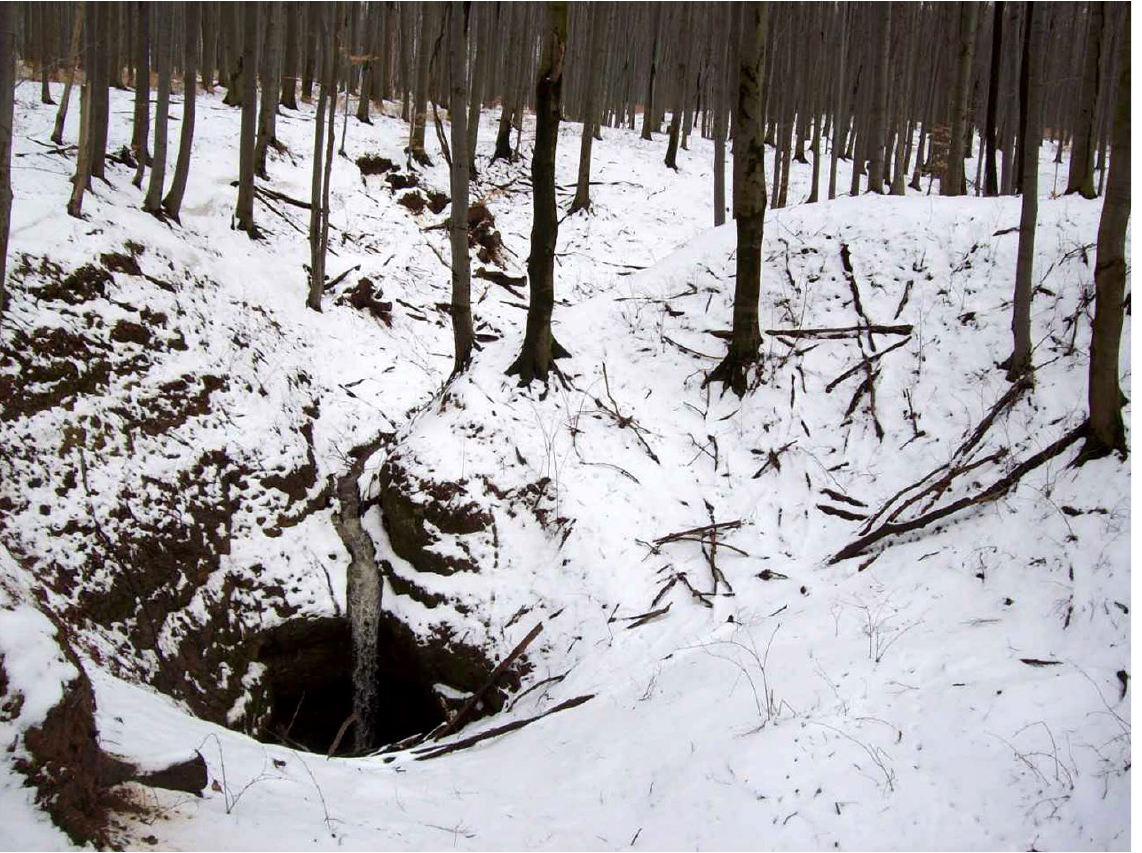
Figure 8. Ponor of Macskalik cave (Kab Mountain).